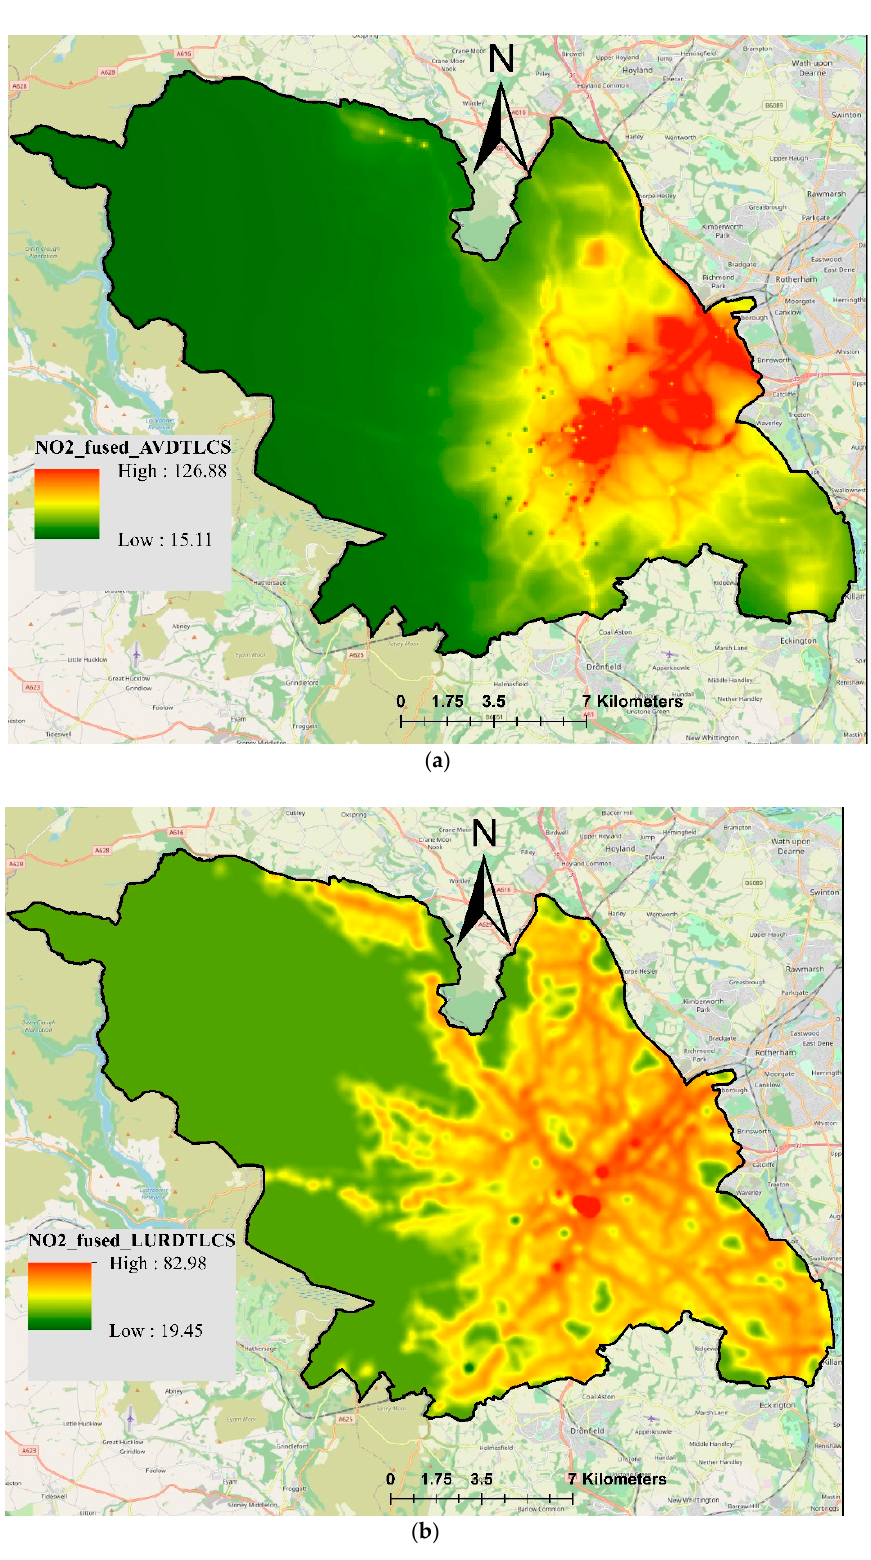
Figure 9. Resulting map of fused NO 2 concentrations (µg/m 3 ) using universal kriging techniques: ( a ) Airviro-DTLCS; ( b ) LUR-DTLCS.